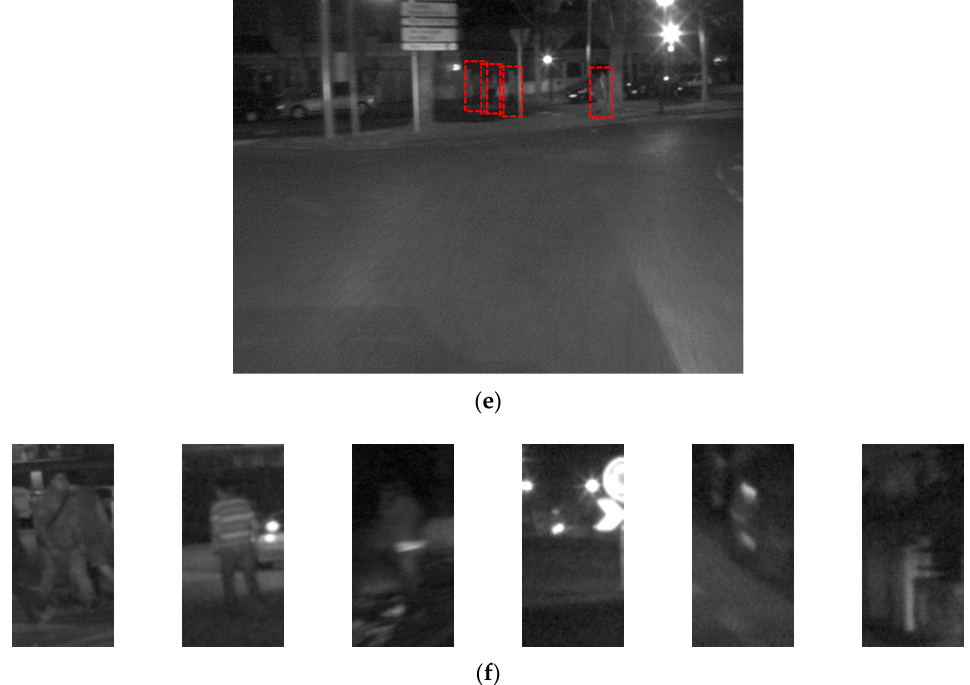
Figure 3. Examples from three databases used in experiments: ( a ) collected images of DNHD-DB1; ( b ) human and background images of DNHD-DB1; ( c ) collected image of KAIST database; ( d ) human and background images of KAIST database; ( e ) collected image of CVC-14 database; and ( f ) human and background images of CVC-14 database. In ( a , c , e ), human areas are shown as red dashed box. In ( b , d , f ), left three figures are human images whereas the right three ones are background images, respectively.